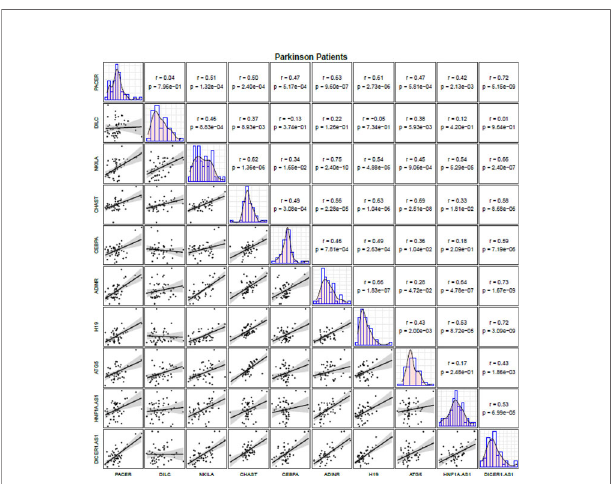
FIGURE 2 | Correlation matrix for illustration of correlation between expression levels of NF- k B-related lncRNAs among PD patients (The distribution of expression levels of each lncRNA in PD patients is shown on the diagonal. Bivariate scatter plots are shown on the bottom of the diagonal. R and P values are shown on the top of the